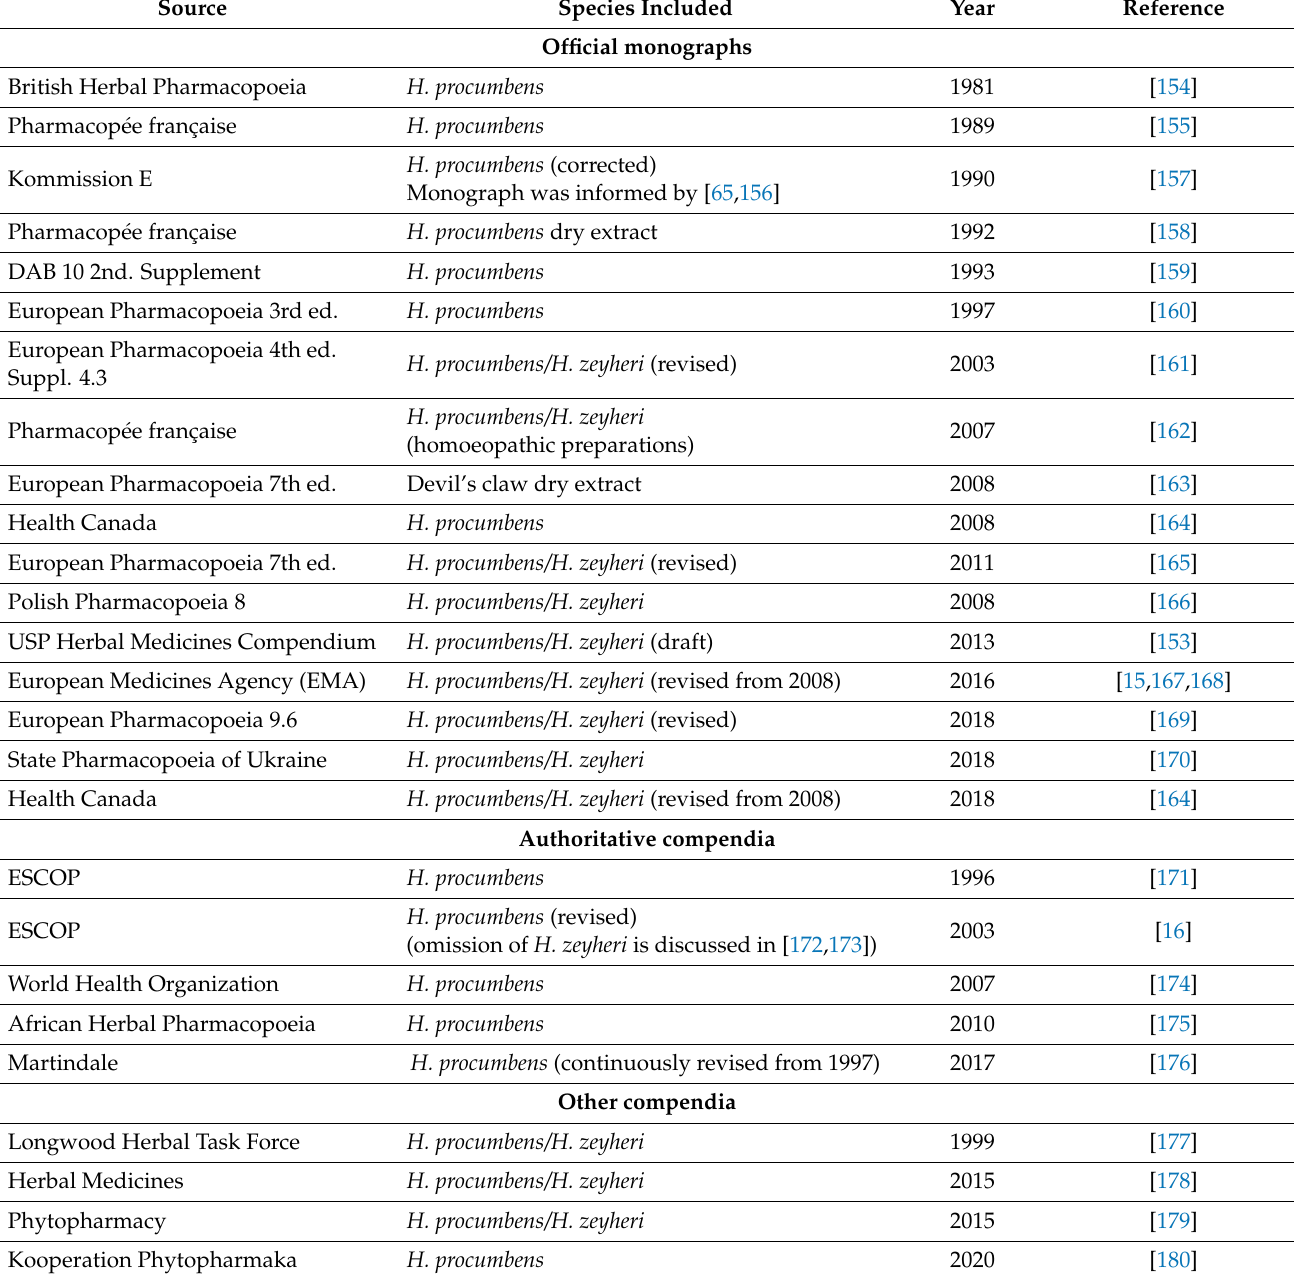
Table 1. Representation of devil’s claw in pharmacopeias and authoritative